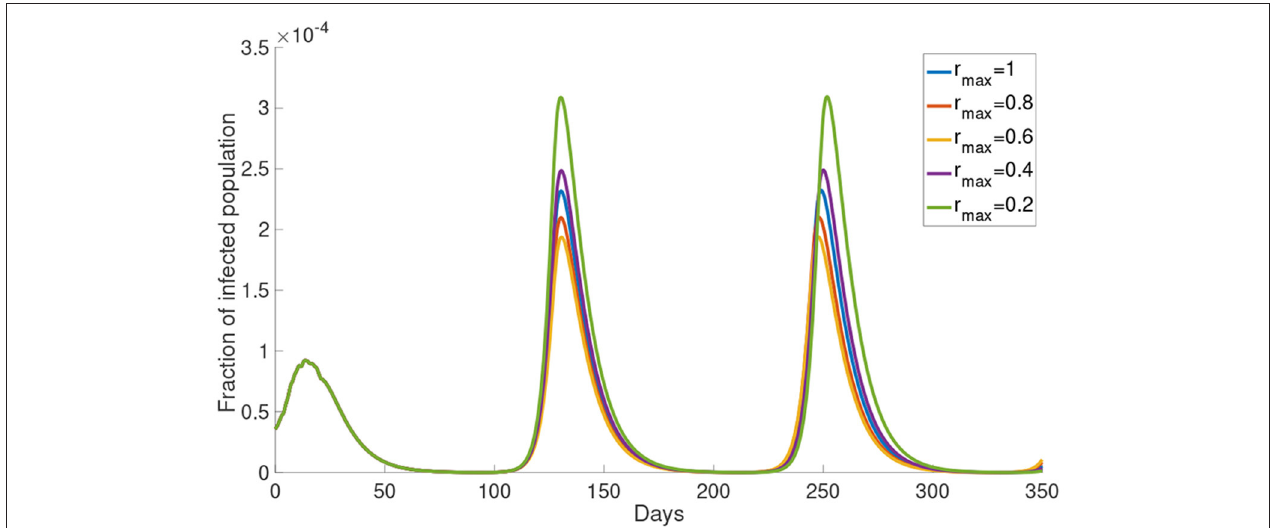
FIGURE 5 | The simulation of the infected population with different r max .